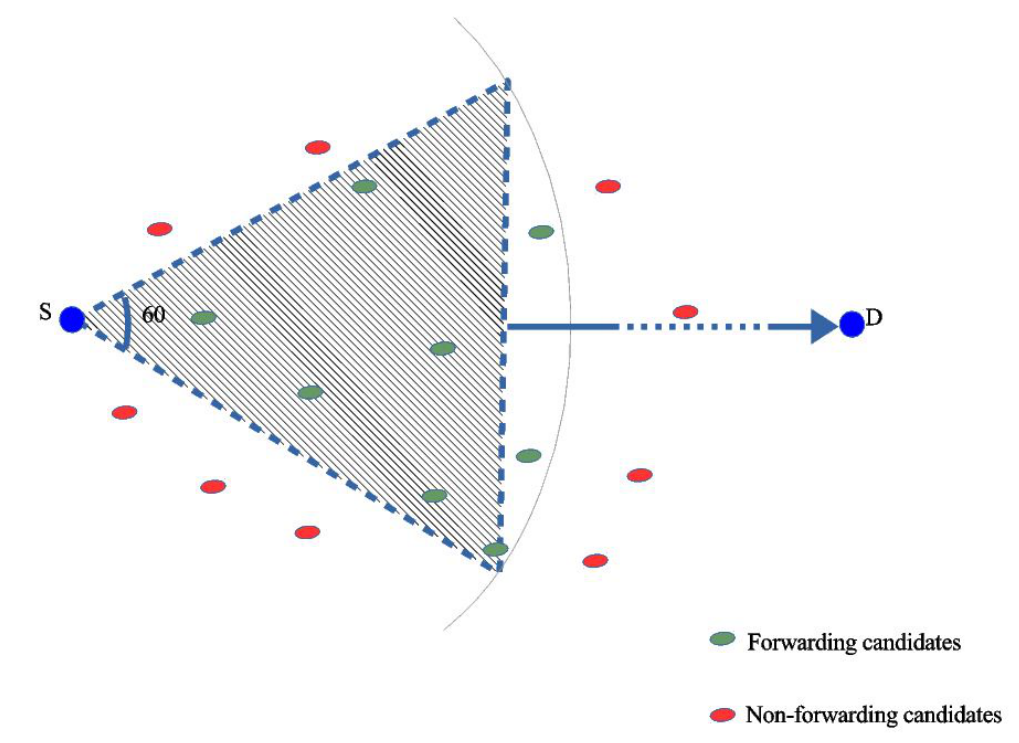
Figure 1. Forwarding